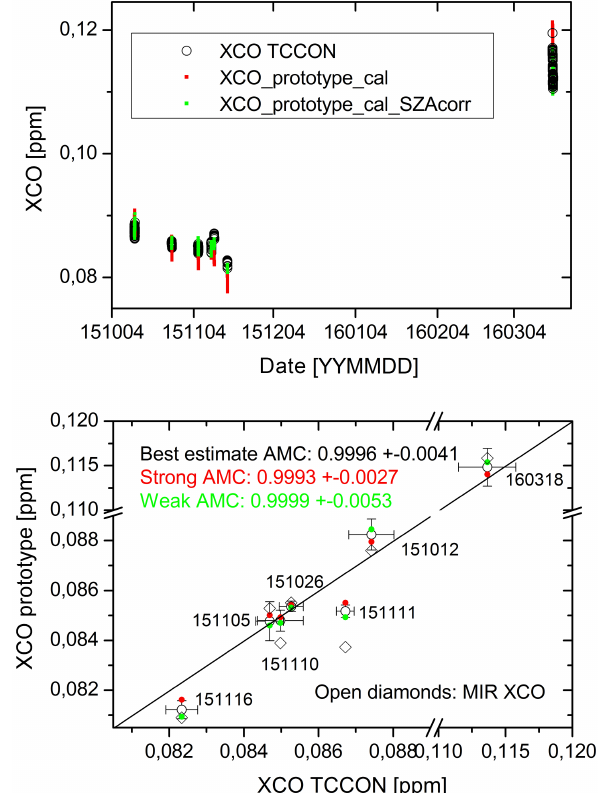
Figure 11. XCO deduced from the dual-channel prototype and the TCCON site Karlsruhe. Upper panel: time series of XCO. Lower panel: XCO values measured with the prototype as a function of the collocated TCCON XCO values (AMC denotes air mass correc- tion). The error bars are the standard deviations of the intraday scat- ter. In the upper panel, all available TCCON values have been taken into account, whereas for the calculation of the statistics shown in the lower panel the TCCON measurements have been restricted to the observing hours of the prototype, because the intraday variabil- ity is not negligible in the case of XCO. As indicated by the cali- bration factors, the choice of the air mass correction does not crit- ically impact the level of agreement found between the prototype and the TCCON XCO observations. The lower panel of the figure in addition shows XCO results derived from high-resolution mid- infrared spectra (open diamonds), analysed as described by Kiel et al. (2016b) (the calibration factor of 0.954 recommended by Kiel et al. has been applied to the mid-infrared data to match with the calibration of the